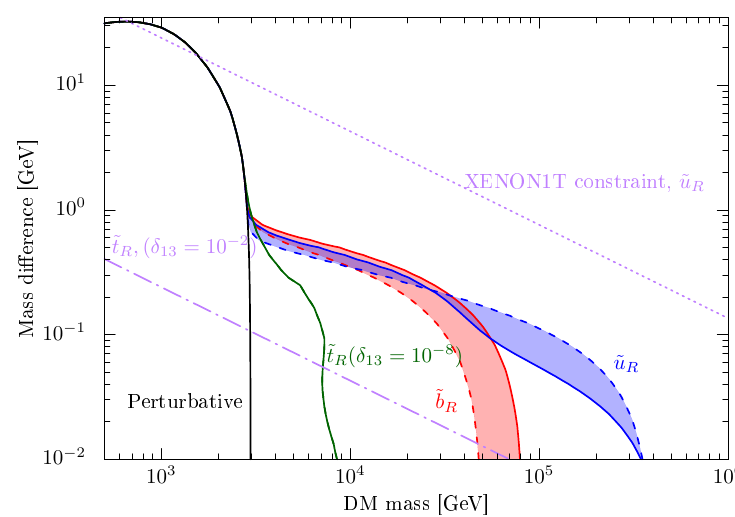
2 = 0 : 12 on the m Figure 7. The contour plot of (cid:10) DM h DM -(cid:1) m plane. The black line shows the result of the perturbative estimation from the (cid:12)rst freeze-out. The blue, red and green lines show the cases of ~ u R , ~ b R and ~ t R , respectively. For the ~ t R we set the mass mixing with the (cid:12)rst generation (cid:14) 13 = 10 (cid:0) 8 . The solid and dashed lines show the estimation with (cid:3) = 0 : 4 and 1 GeV, respectively. We also plot in dotted purple line the current constraint on the dark matter direct detection with XENON1T [92], for the case of the bino LSP and ~ u R NLSP. The region below this line is disfavored. resonance (~ q (cid:3) ~ q ) into SM particles also increases ((cid:12)gure 2) accordingly the dark matter abundance is smaller than the ~ u R case. For the ~ b R case, the chemical decoupling occurs at T 100 MeV and ~ b R cannot annihilate at T 10 MeV, where the annihilation cross (cid:24) (cid:24) section is enhanced. Thus at small mass di(cid:11)erences, the abundance for the ~ b R case is